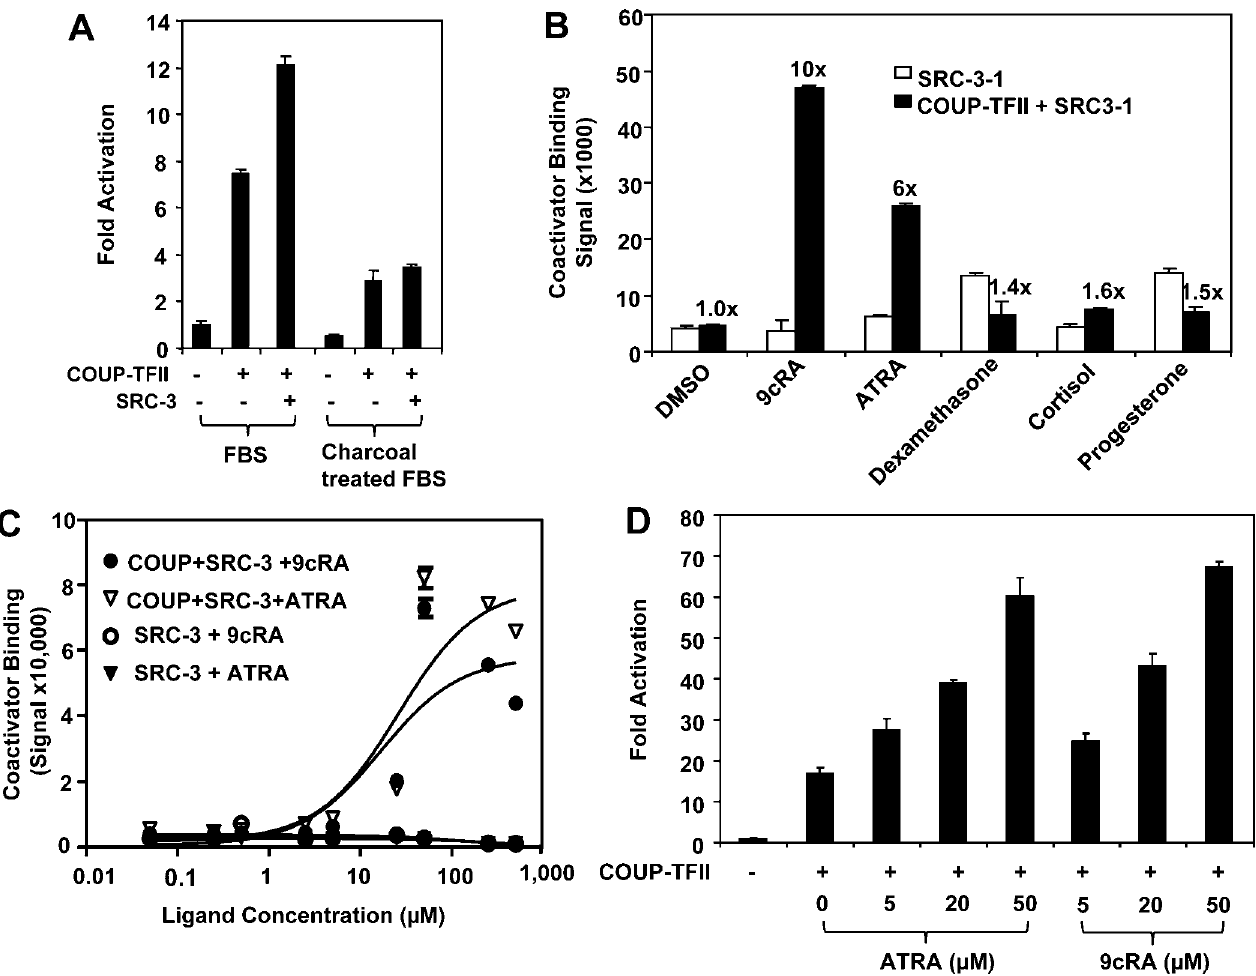
Figure 7. COUP-TFII Is Activated by Retinoid Acids (A) Effects of charcoal-treated FBS on COUP-TFII activation in the presence or absence of SRC-3 coactivator. The basal activity of the NGFI-A reporter construct in the presence of FBS and absence of COUP-TFII and SRC-3 is set as 1. (B) Addition of 50 l M of 9cRA or ATRA to promote COUP-TFII binding to SRC-3–1 coactivator motif where the addition of steroids (50 l M) has little effect. (C) Concentration-response curves of 9cRA and ATRA, which show the binding affinity (EC50) of 9cRA and ATRA is 17 l M and 26 l M, respectively. (D) Effects of ATRA and 9cRA on COUP-TFII activation of the NGFI-A promoter in COS-7 cells.